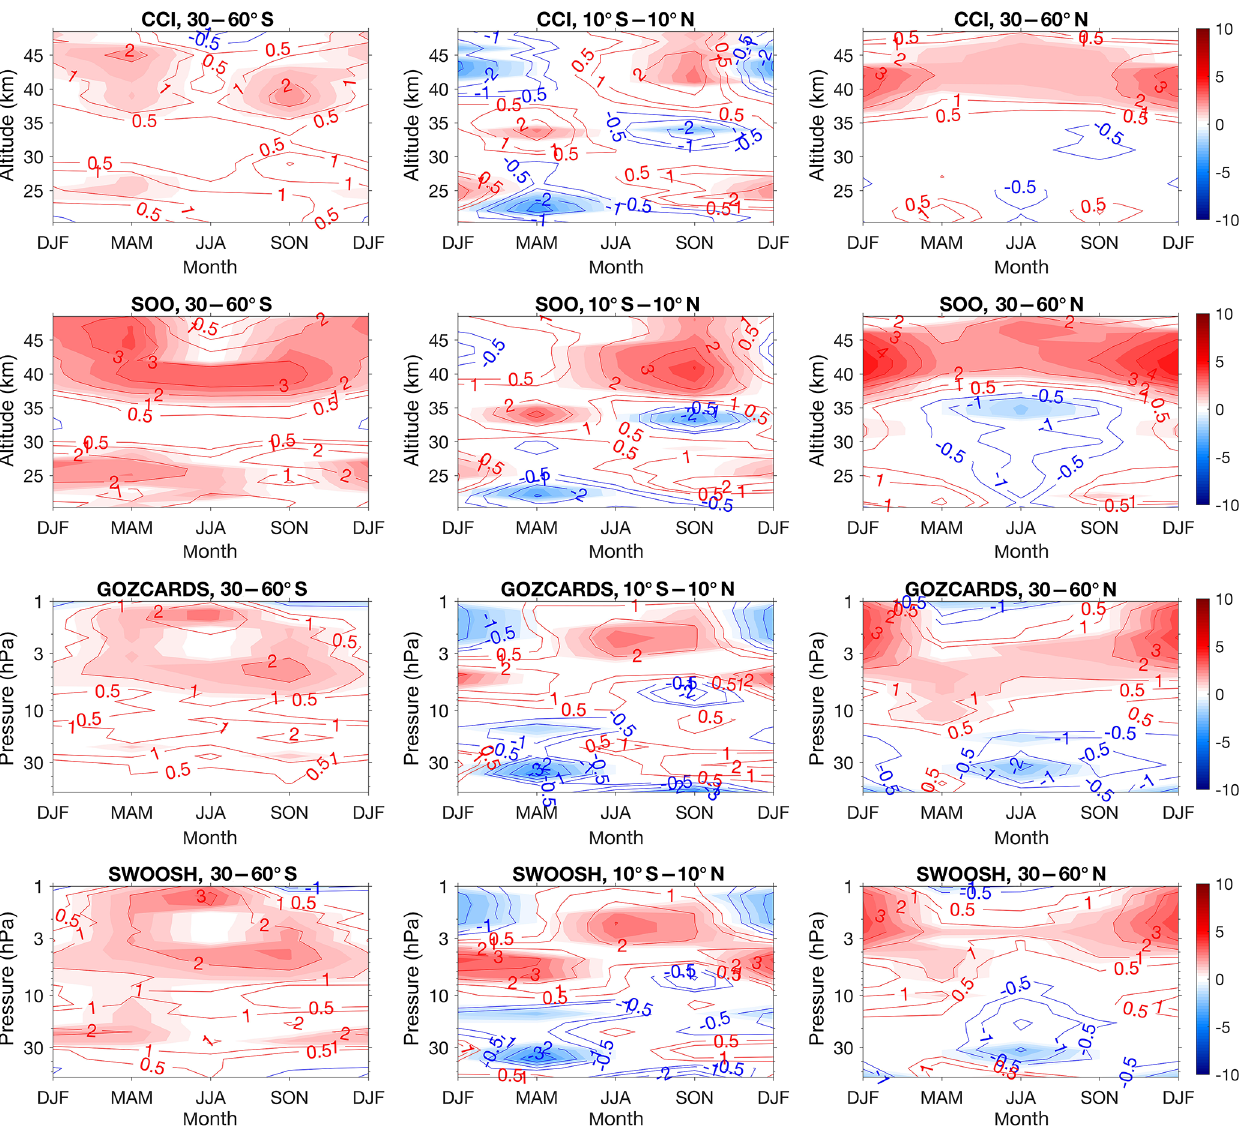
Figure 4. Altitude–season variation of linear trends in ozone for each of the merged data sets calculated over 2000–2018 for three selected latitudinal bands. Data are presented on their natural vertical coordinate: altitude grid for CCI and SOO and pressure grid for GOZCARDS and SWOOSH. The shading denotes trends that are significant at the 95%